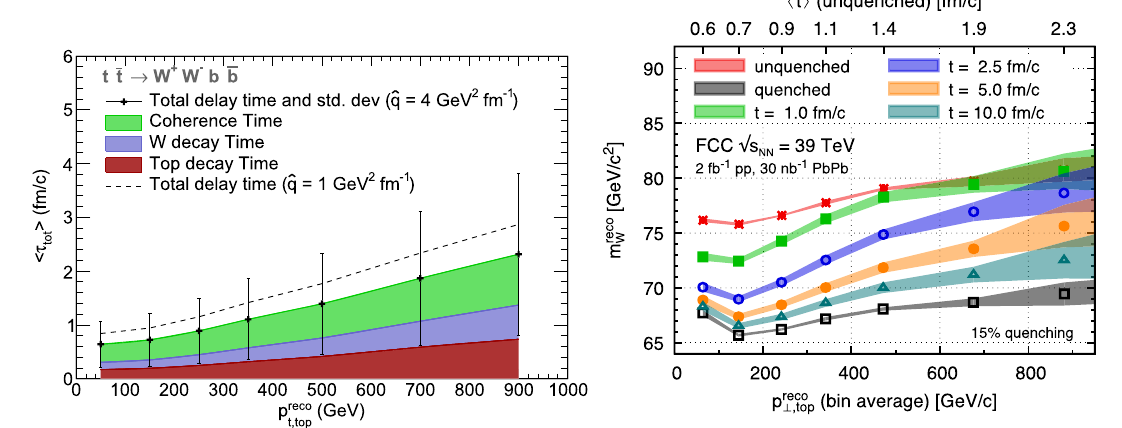
Fig. 16.3 Left: total delay time for ˆ q = 4 GeV 2 / fm as a function of the top transverse momentum (black dots) and its standard deviation (error bars). The average contribution of each component is shown as a coloured stack band. The dashed line corresponds to a ˆ q = 1 GeV 2 /